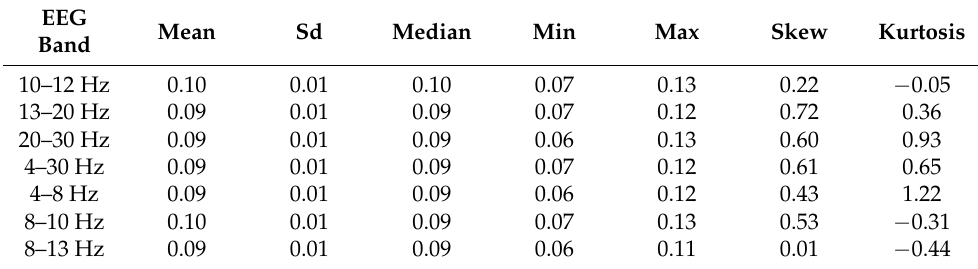
Table 4. Descriptive statistics of modularity metric for narrow EEG